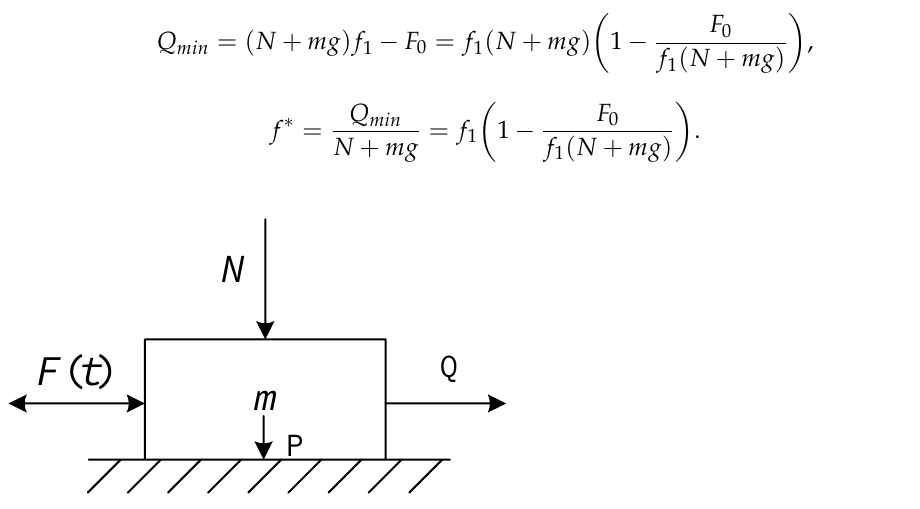
Figure 1. The vibration model of parallel force.